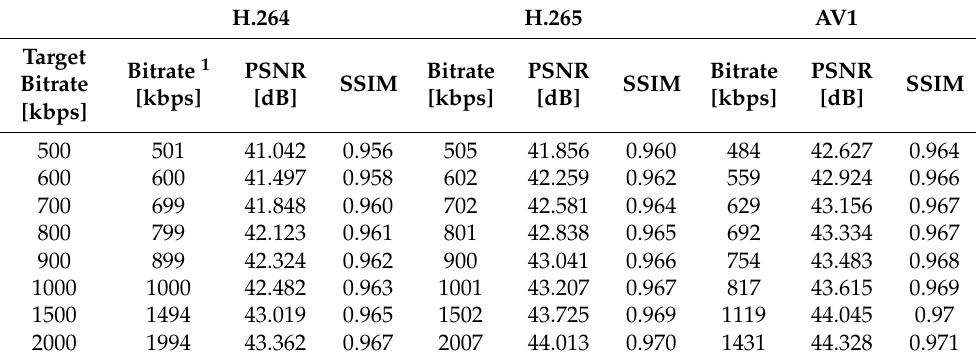
Table 3. PSNR an SSIM results for the ‘Beauty’ video test